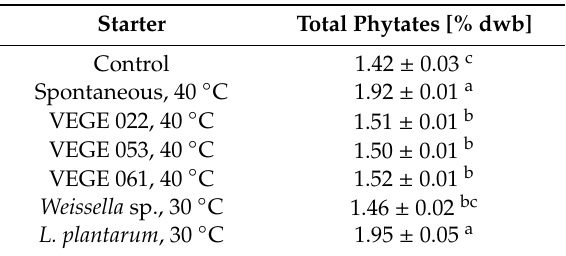
Table 1. Total phytates content [% dry weight basis (dwb)] measured with the Megazyme kit in powders fermented by di ff erent starter cultures. Standard deviations are shown ( n = 3). Values sharing a letter are not statistically di ff erent.